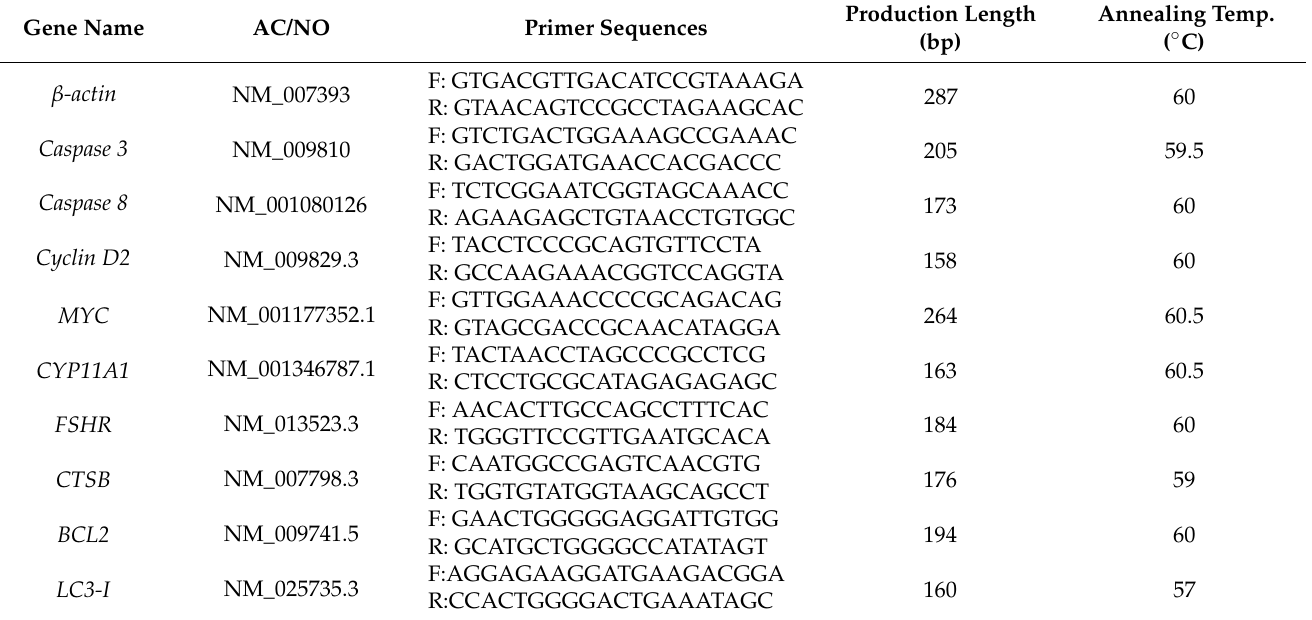
Table 1. Primer sequences for quantitative real-time PCR and si-CTSB